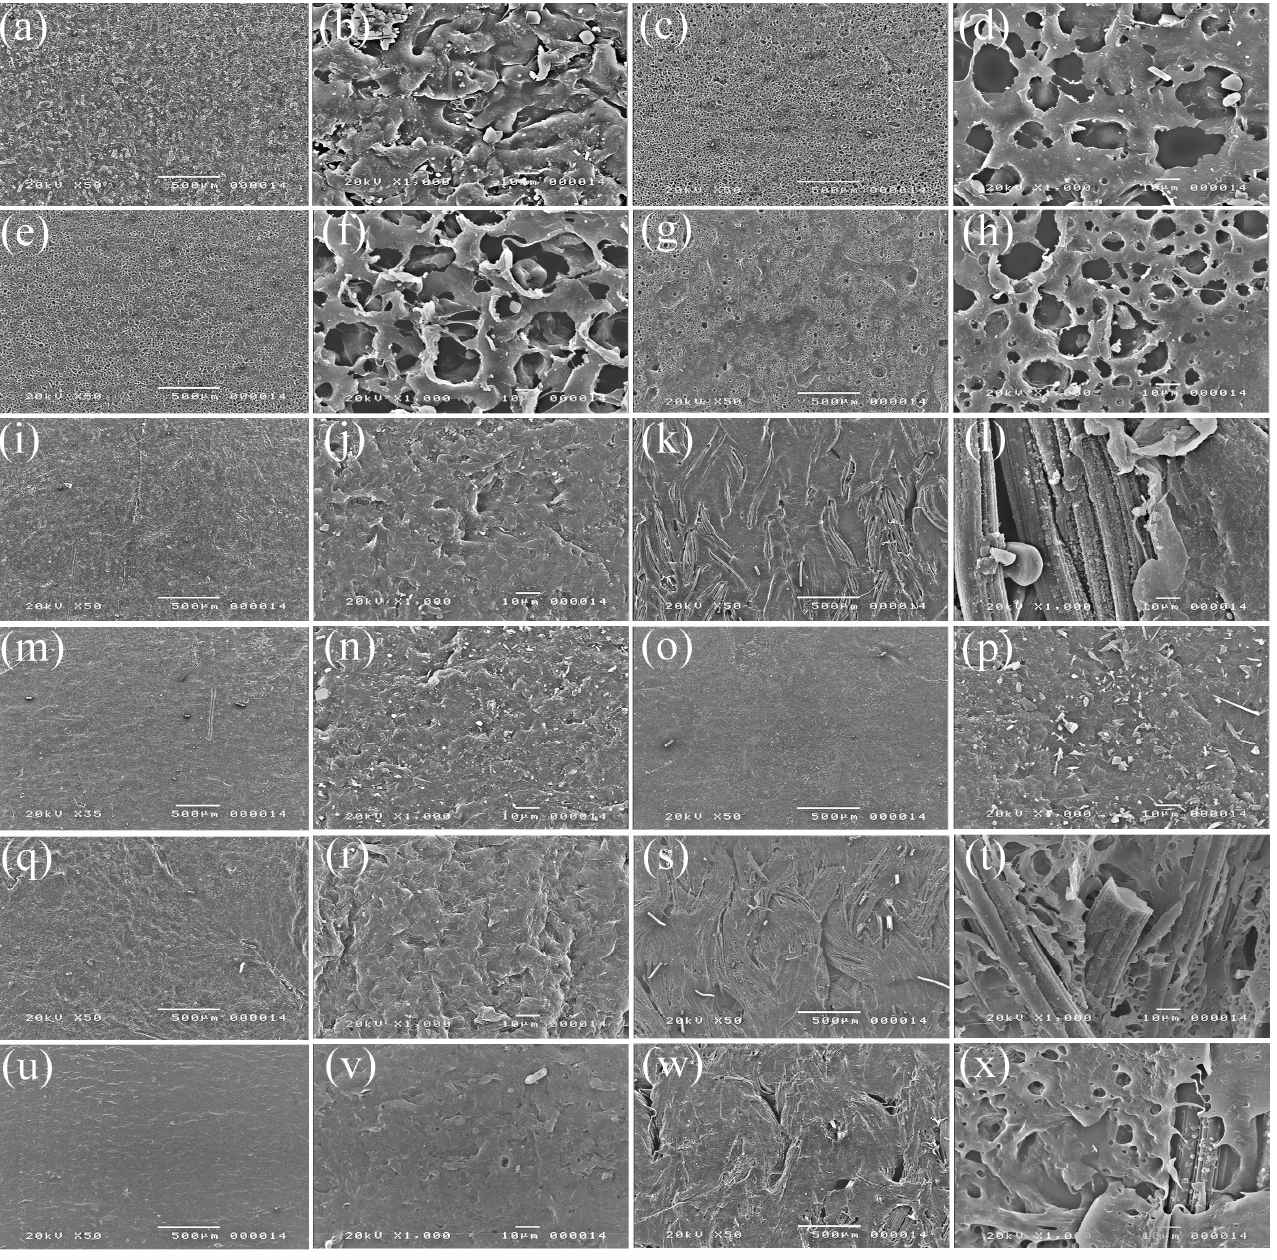
Figure 1. SEM images showing the microstructure of fabricated cefazolin loaded samples: ( a )